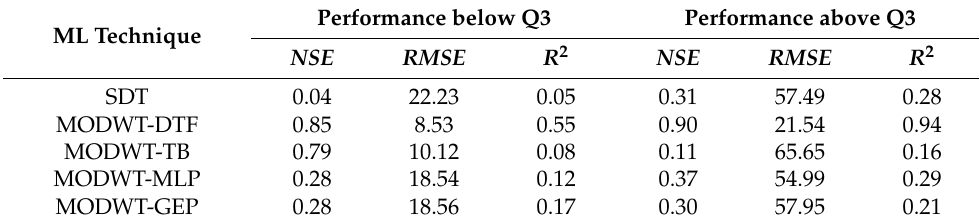
Figure 13. Comparative analysis of the best models. Table 6. Summary of best performance models at low flows and high